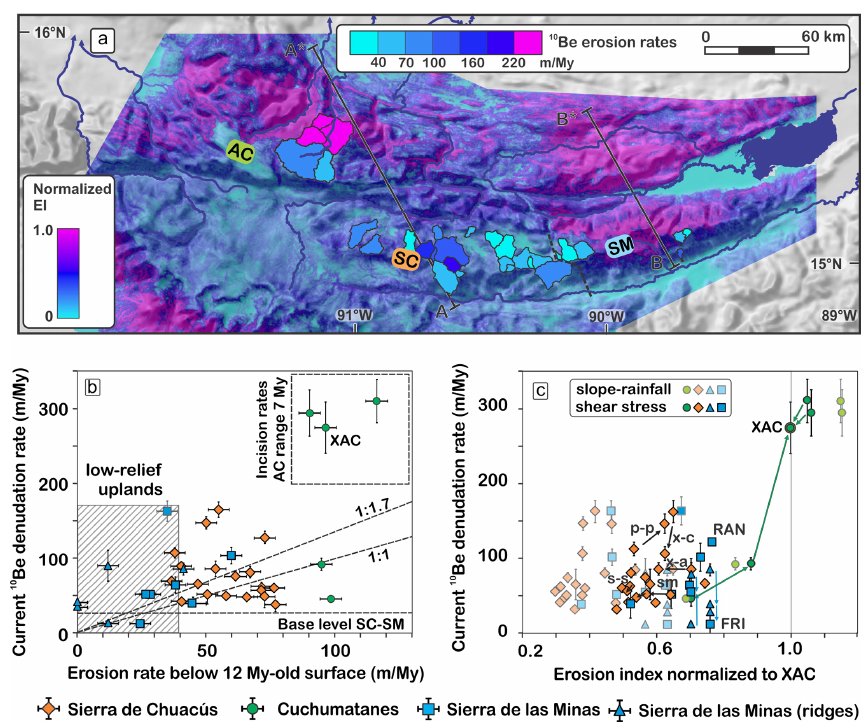
Figure 13. (a) Map showing the spatial distribution of normalized catchment-wide 10 Be erosion rates superposed to the predicted spatial distribution of erosion according to the normalized erosion index. (b) Catchment-wide 10 Be erosion rates as a function of catchment-averaged precipitation. (c) Catchment-wide 10 Be erosion rates as a function of catchment-averaged slope (from quartz-contributing slopes) Arrows show downstream connections between the nested catchment within the AC range. The dashed line shows the linear correlation within AC range data, with the correlation coefficient ( r 2 ) reported next to the